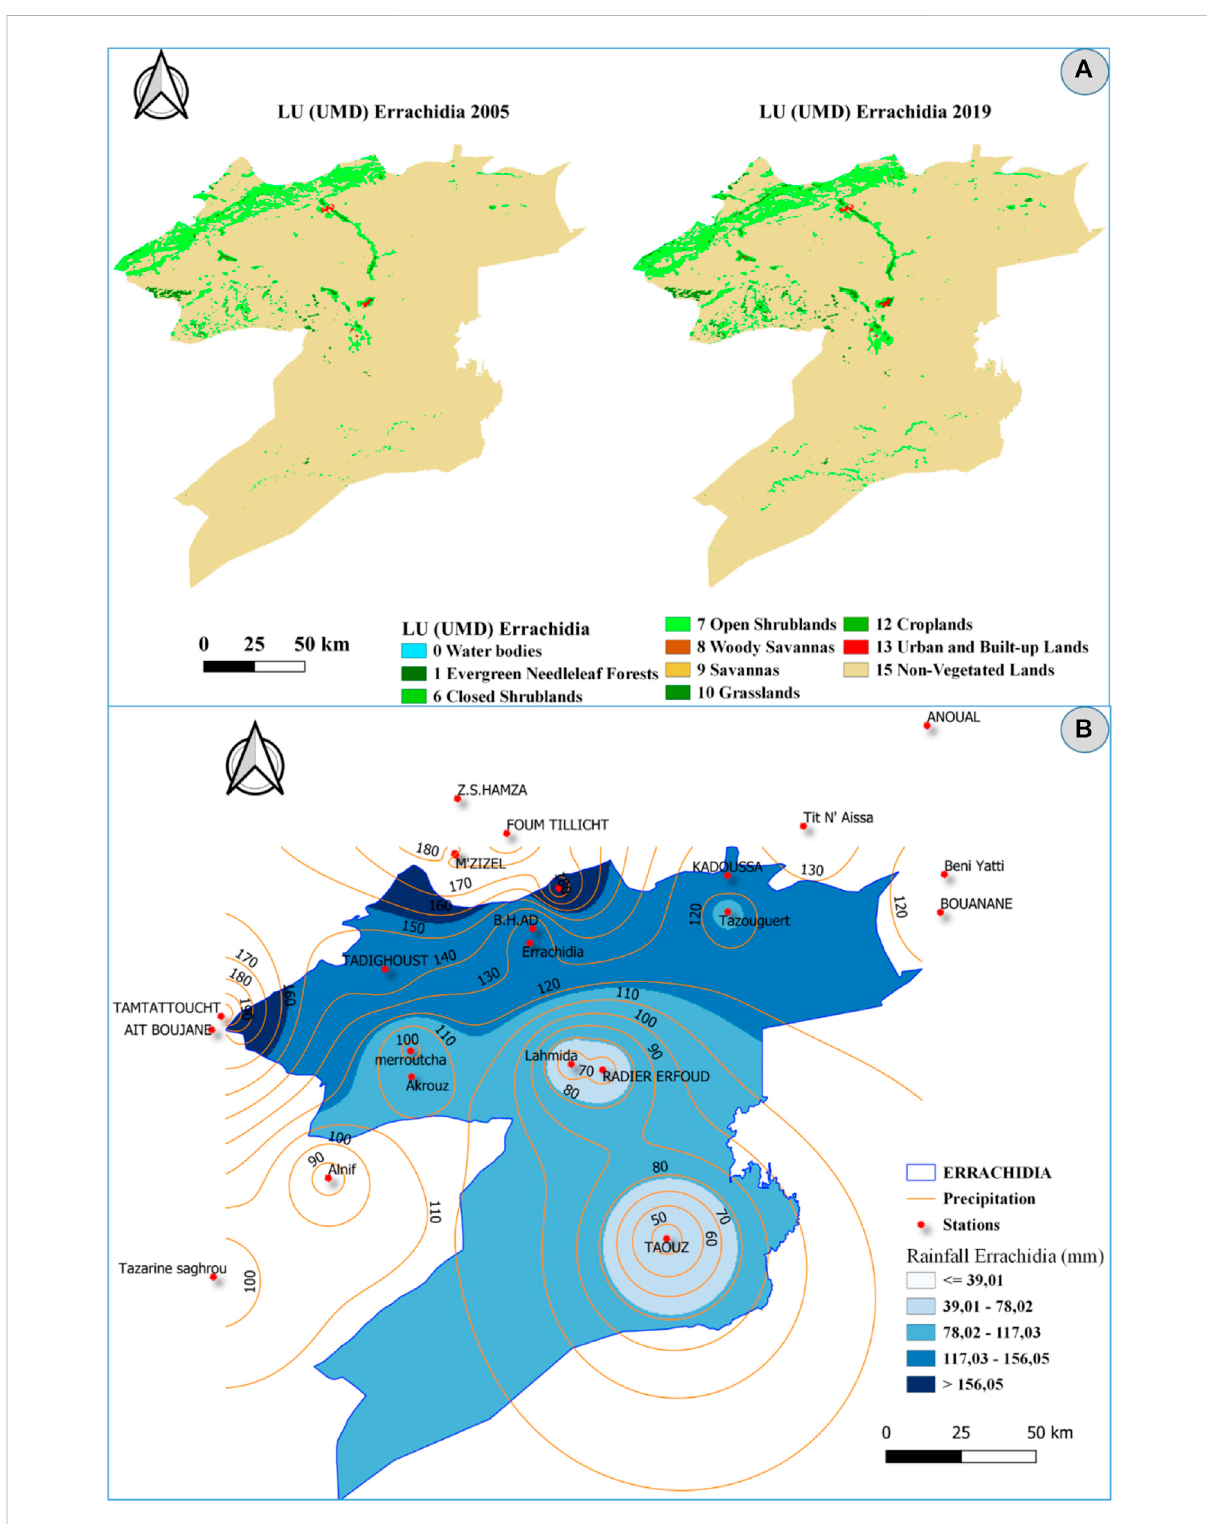
FIGURE 2 CharacteristicsoflanduselandcoverandprecipitationofErrachidiaprovince. (A) LULCchangeand (B) precipitationofthestudiedperiod.Data ofLULC:UniversityofMaryland(UMD)(Michaeletal.,2021);UMDschemeareprovidedata0.05 ° spatialresolution.Thedatasourceofprecipitations: Archives of Agence des Bassins Hydrauliques of Guir, Ziz, Rheris, and Maider, see also Table